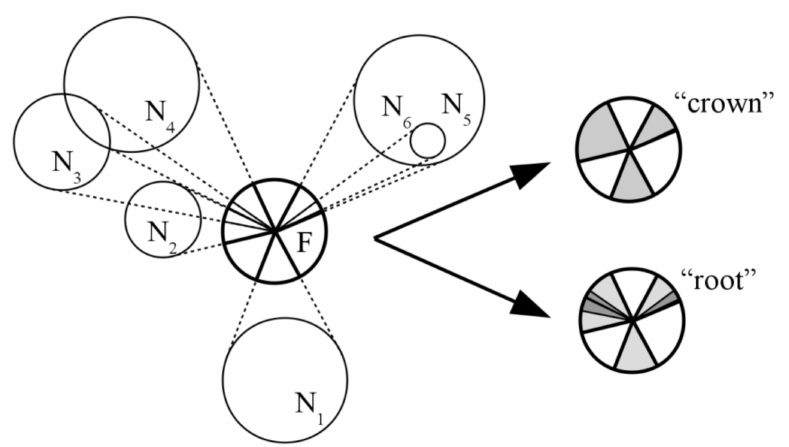
Figure 1. The schematic representation of the calculation of the angular competition index . Influence zones of neighbor trees N 1 –N 6 generate sectors of the influence zone of the focal tree F. Combining these sectors with and without taking into account the overlapped areas produces the components of the competition index related to the root and crown competition, respectively. The intensity of gray filling denotes the competition